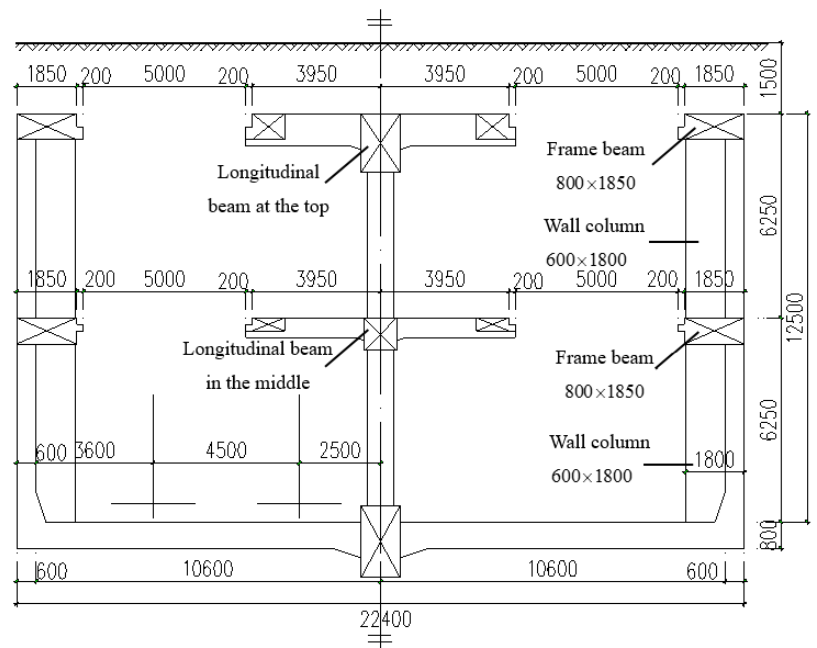
Figure 11. Section of the opening (unit: mm).